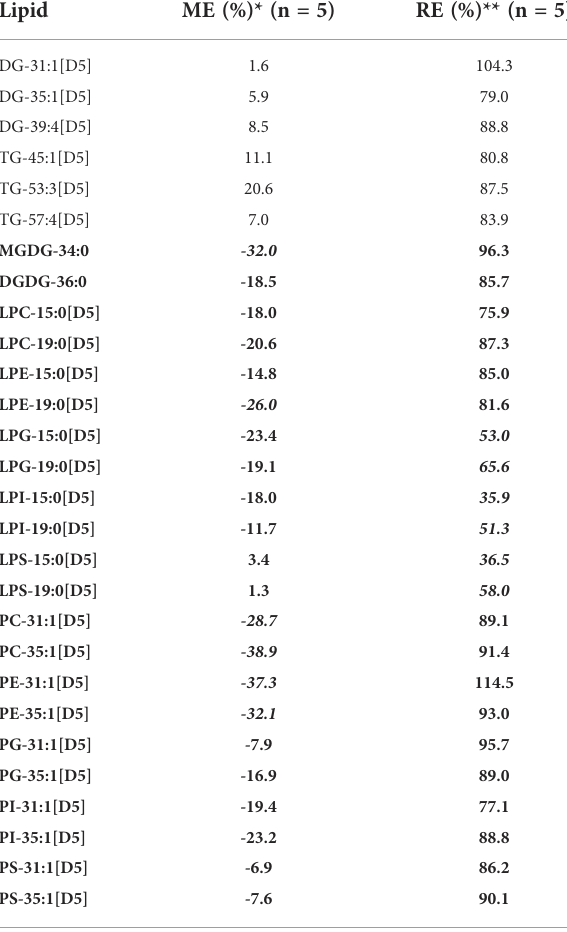
TABLE 2 Matrix effect (%) and recovery ef fi ciency (%) for non-polar and polar lipids. Lipid ME (%)* (n =